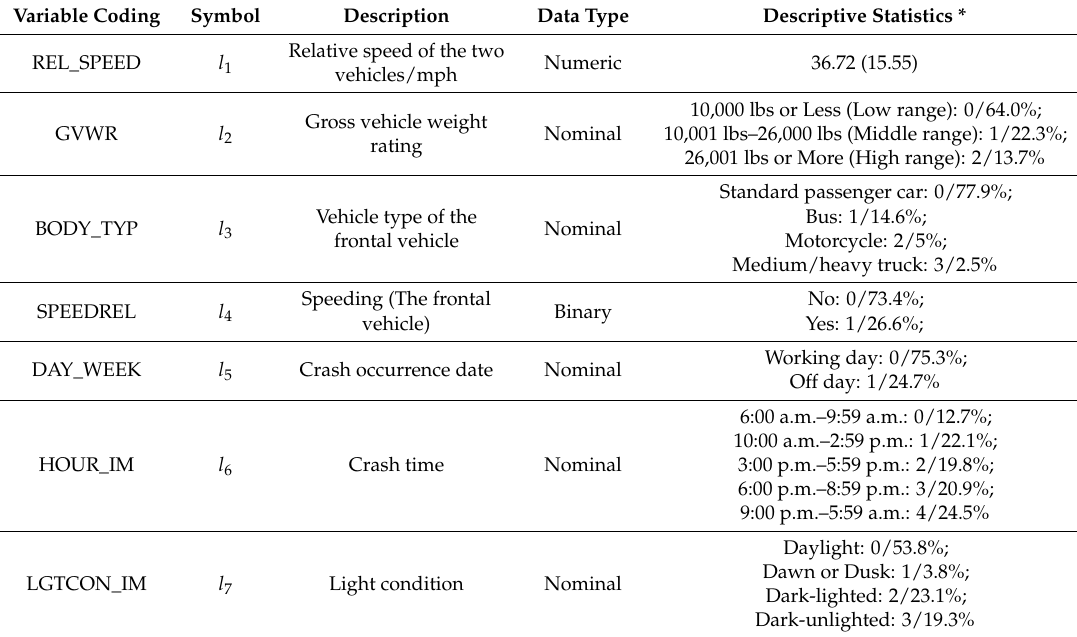
Table 1. Description of the related variables of the crash injury